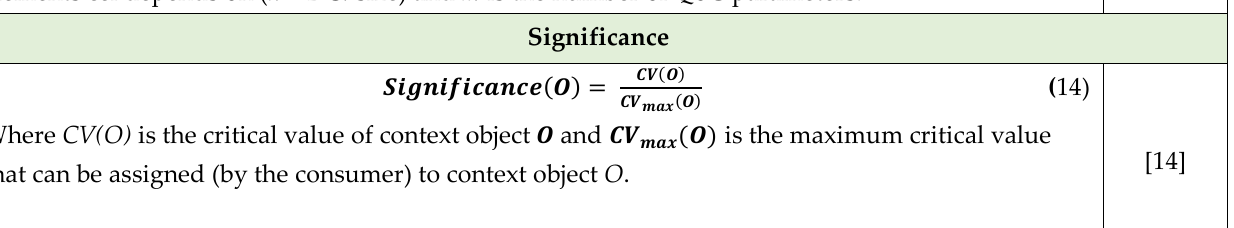
Table 5 . Textual/Numerical scale for relative importance of QoC attributes